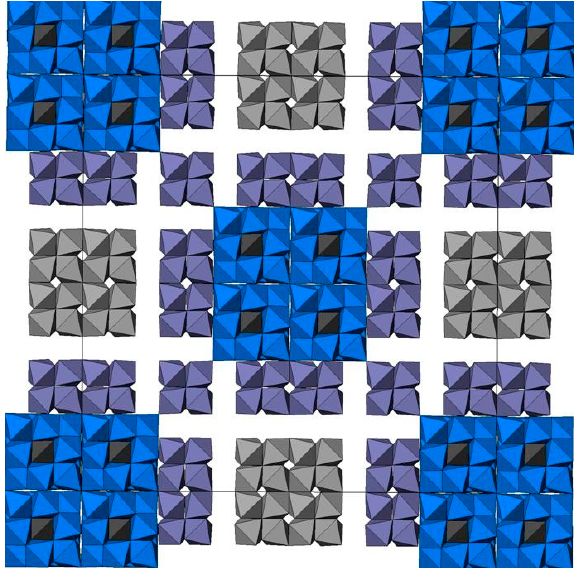
Figure 1. Combination of murataite 3C (blue)–pyrochlore (gray) modules and pyrochlore-type blocks (violet) in the structure of murataite 8C polysome.